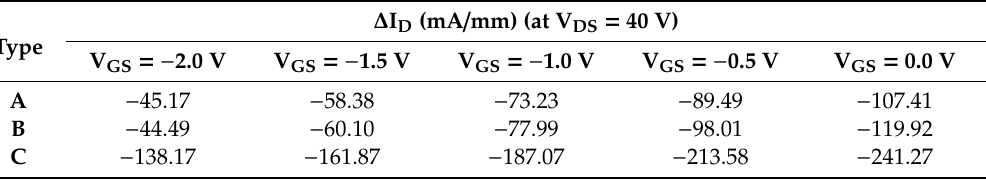
Figure 12. Saturation current characteristics for MIS-HEMT with and without the self-heating e ff ect (SHE) as a normally-on device: ( a ) sample A, ( b ) sample B, and ( c ) sample C. Table 3. Drain current variation due to the self-heating e ff